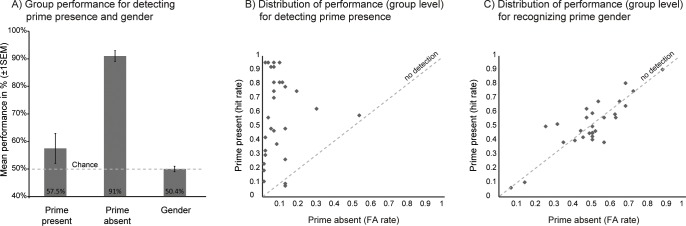
Behavioral data for the prime visibility control task.Assessment of prime visibility and gender awareness was performed after the fMRI experiment. (A) Performance of the group for detecting the presence and the content of face primes. (B) Plot of individual’s hit rate against false alarm (FA) rates for detecting the presence of the prime or (C) recognizing its gender. There was a large inter-individual variability in prime detection scores despite a general inability to consciously access gender information (note that subjects were informed of the occasional presence of primes in the behavioral test after the fMRI experiment, but not before scanning).